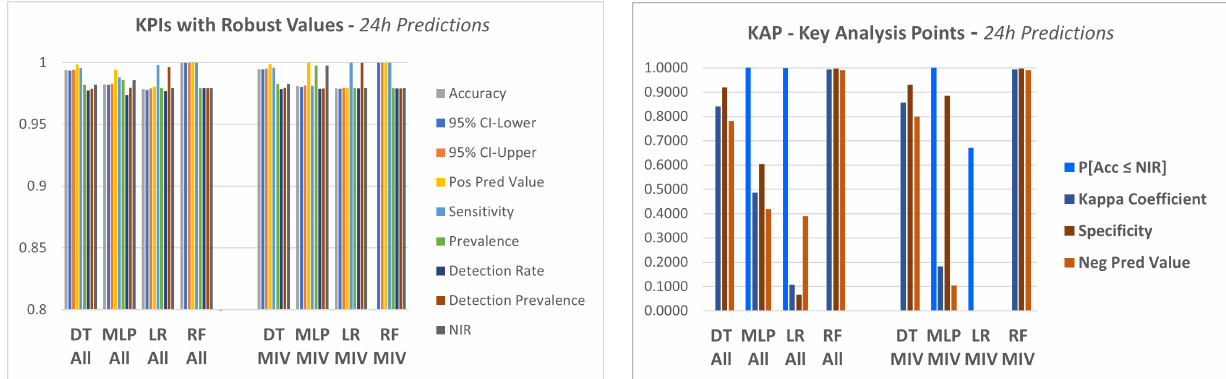
Figure 10. Methods Comparison by KPIs for Alarm Prediction in 12 h.